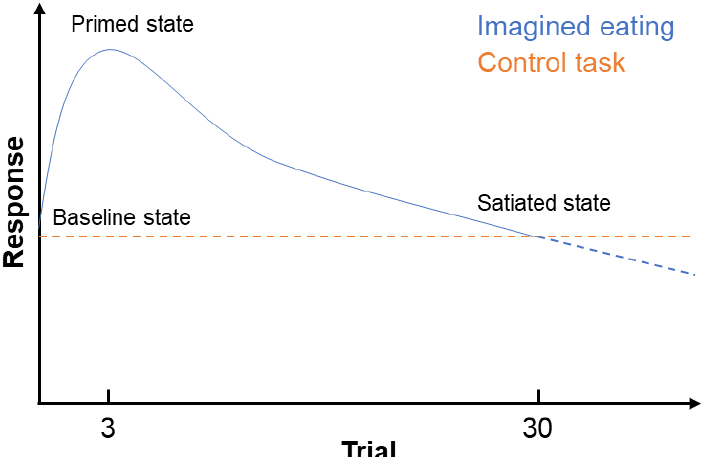
Figure 5. Hypothetical dose–response relationships of the imagined eating and control tasks. The curves are substantially different, yet cross around 30 trials, i.e., the experimental observation. Knowledge of the primed state stems from prior online studies (currently under review). The figure is adapted from Crolic and Janiszewski [28].